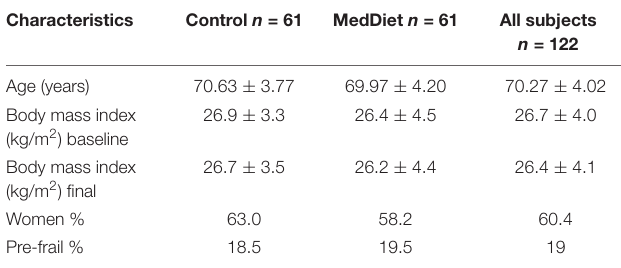
TABLE 2 | Physical features of the study